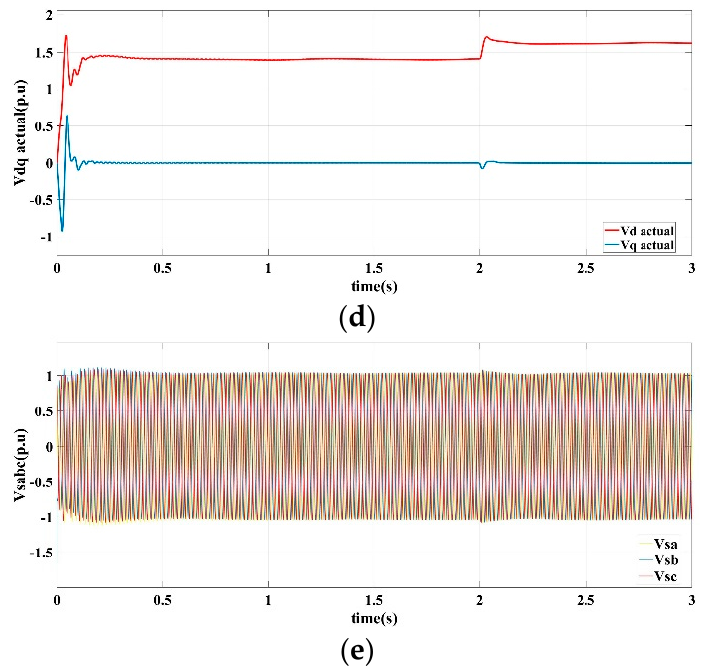
Figure 7. Fault-tolerant control response curve in scenario II. ( a ) current error estimation of d -axis and q -axis ( b ) voltage error estimation of d -axis and q -axis ( c ) d -axis and q -axis current output, ( d ) d -axis and q -axis voltage output, ( e ) Three-phase voltage output.